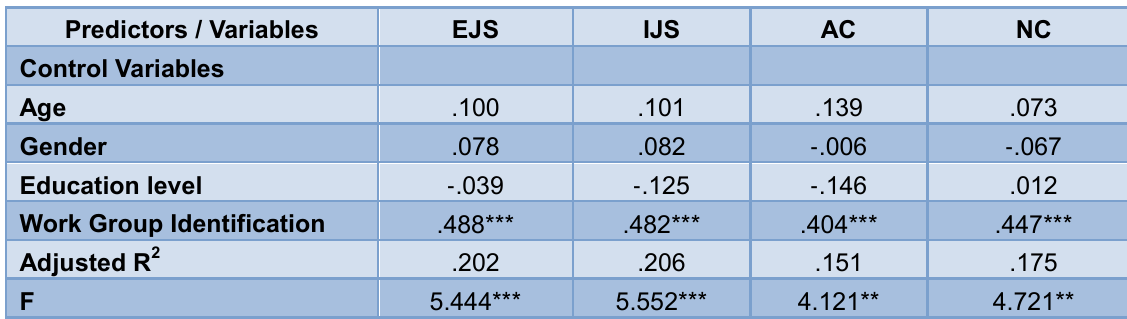
Table 2 Regression Results on Job Satisfaction and Organisational Commitment **. Correlation is significant at 0.01 level (2-tailed) ***. Correlation is significant at 0.001 level (2-tailed) EJS = Extrinsic Job Satisfaction; IJS = Intrinsic Job Satisfaction; AC = Affective Commitment; NC = Normative